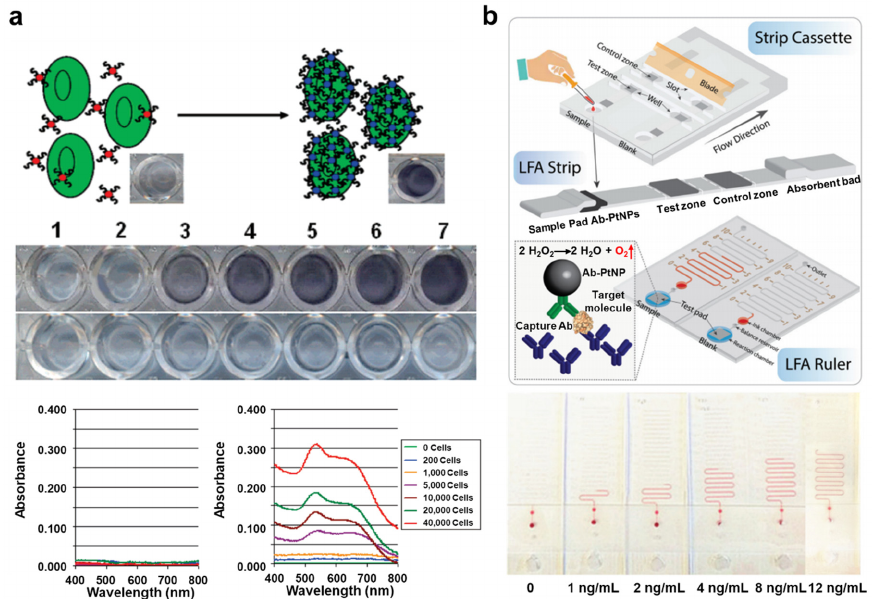
Figure 5. ( a ) Schematic images of aptamer-conjugated gold nanoparticle-based assay system and colorimetric analysis of target cancer cells. This figure is reproduced from [82] (© 2018 American Chemical Society); ( b ) Schematic images of lateral flow assay-based microfluidic device and verification process of the target molecule by distance traveled by ink. This figure is reproduced from [85] (© 2019 Royal Society of Chemical).